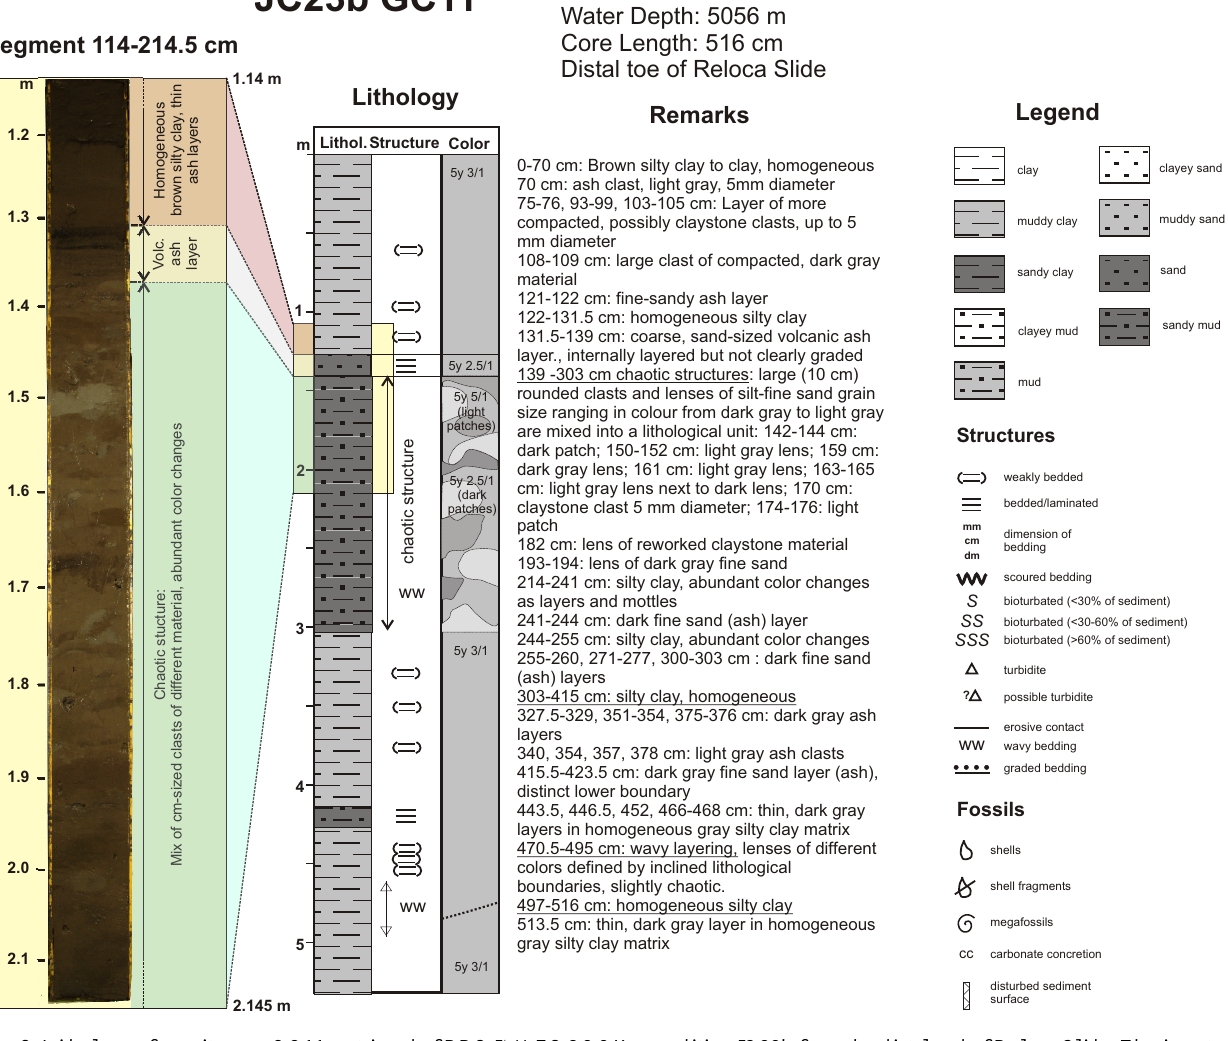
Fig. 6. Lithology of gravity core GC11, retrieved of RRS JAMES COOK expedition JC23b from the distal end of Reloca Slide. The inserted photo highlights the transition from homogeneous, silty clay and a volcanic ash bed of the uppermost 139cm of the core (post-emplacement sediments) to a thick bed of chaotically stacked sediment clasts (debrite deposit), most probably genetically related to Reloca Slide. The debrite is well visible because of its patchy